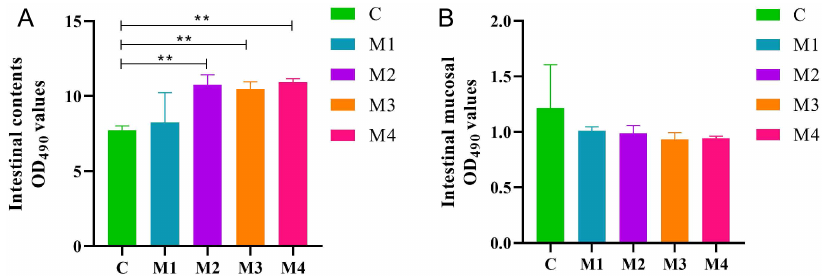
Figure 7. Effects of adenine combined with Folium sennae modeling on the intestinal microbial activity of diarrhea mice. (A) Microbial activity of intestinal contents. (B) Microbial activity of intestinal mucosa. Data were expressed as mean ± standard deviation, n = 6, * P < .05, ** P <